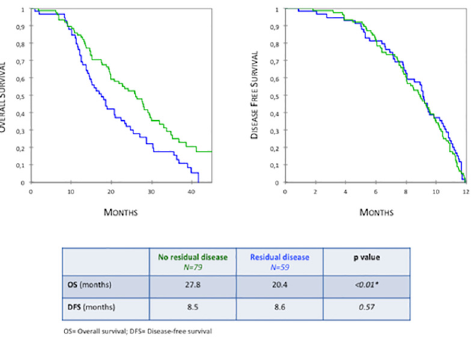
Fig 1. Overall Survival and Disease-Free Survival in patients with early relapse according to residual disease status (Kaplan Meier